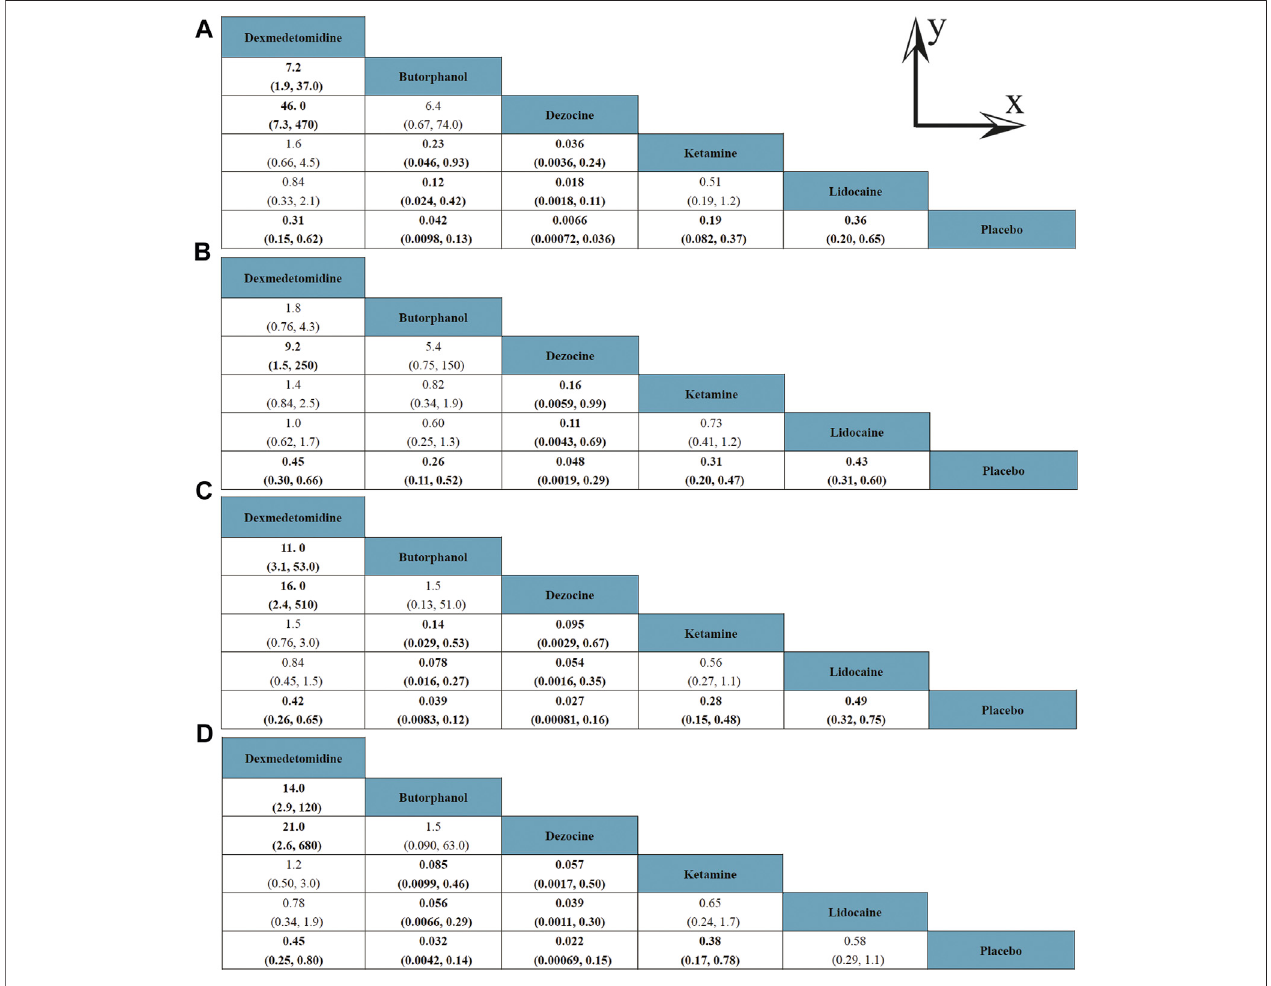
FIGURE3| Ef fi cacyofdifferentcomparisons ofdrugsbyRRsand corresponding 95%CrIs; (A) IncidenceofOIC; (B) MildseverityofOIC; (C) Moderateseverityof OIC; and (D) Severe severity of OIC. All results were displayed as the ratio of the Y axis versus X axis. Bold fonts indicated p-value < 0.05.